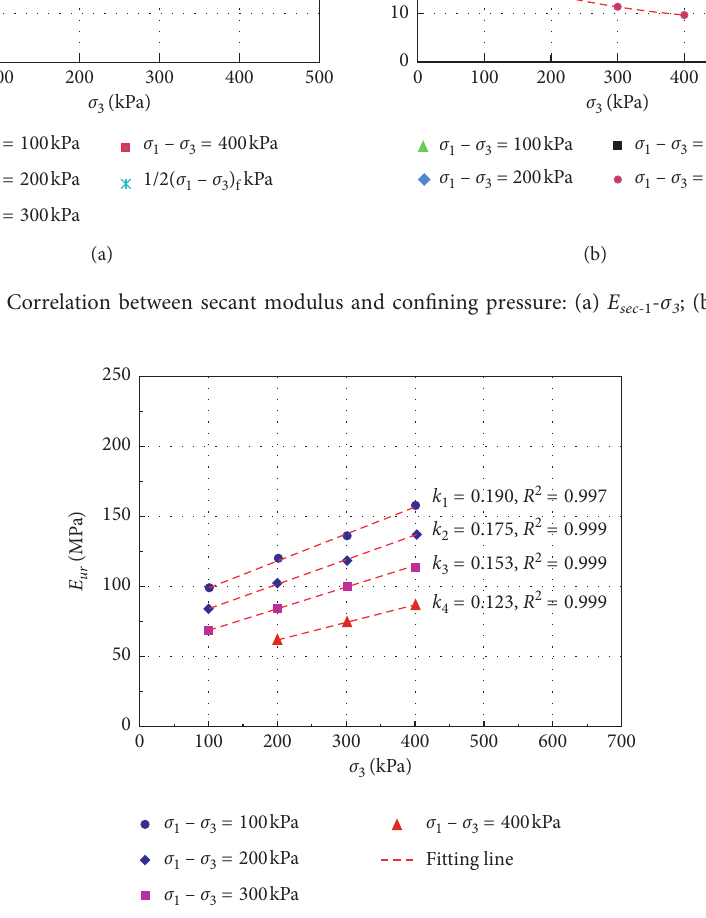
Figure 11: Correlation between deviator stress and unloading modulus.